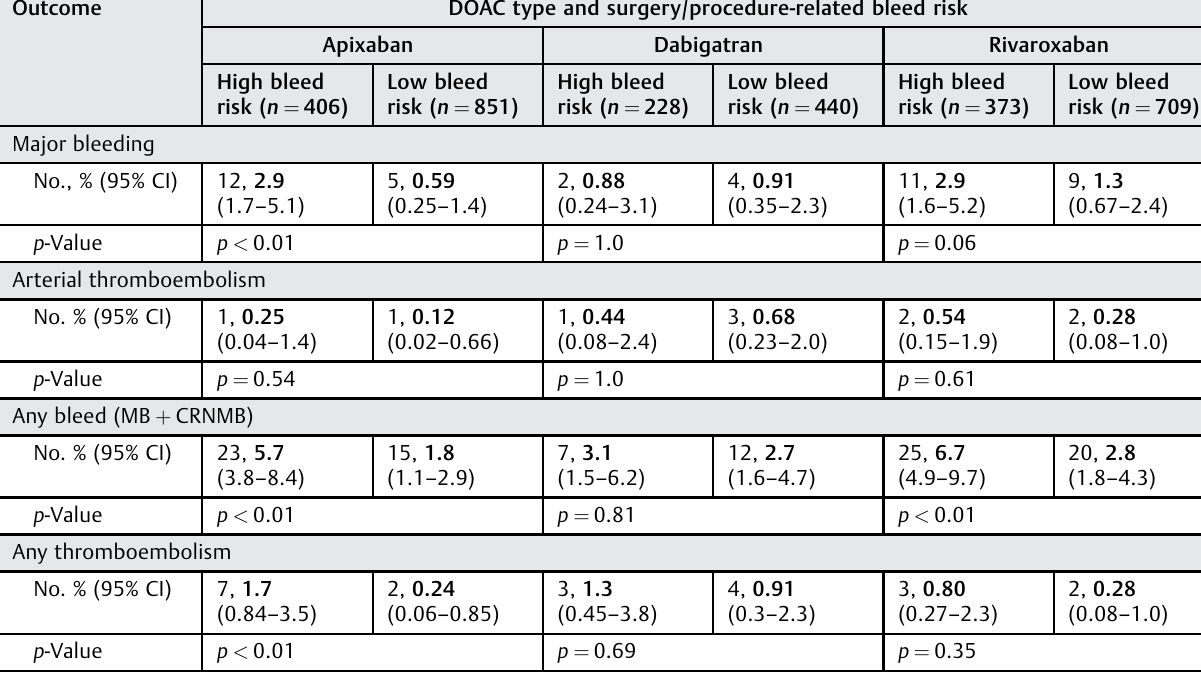
Table 4 Effect of surgery/procedure-related bleed risk on clinical outcomes Outcome DOAC type and surgery/procedure-related bleed